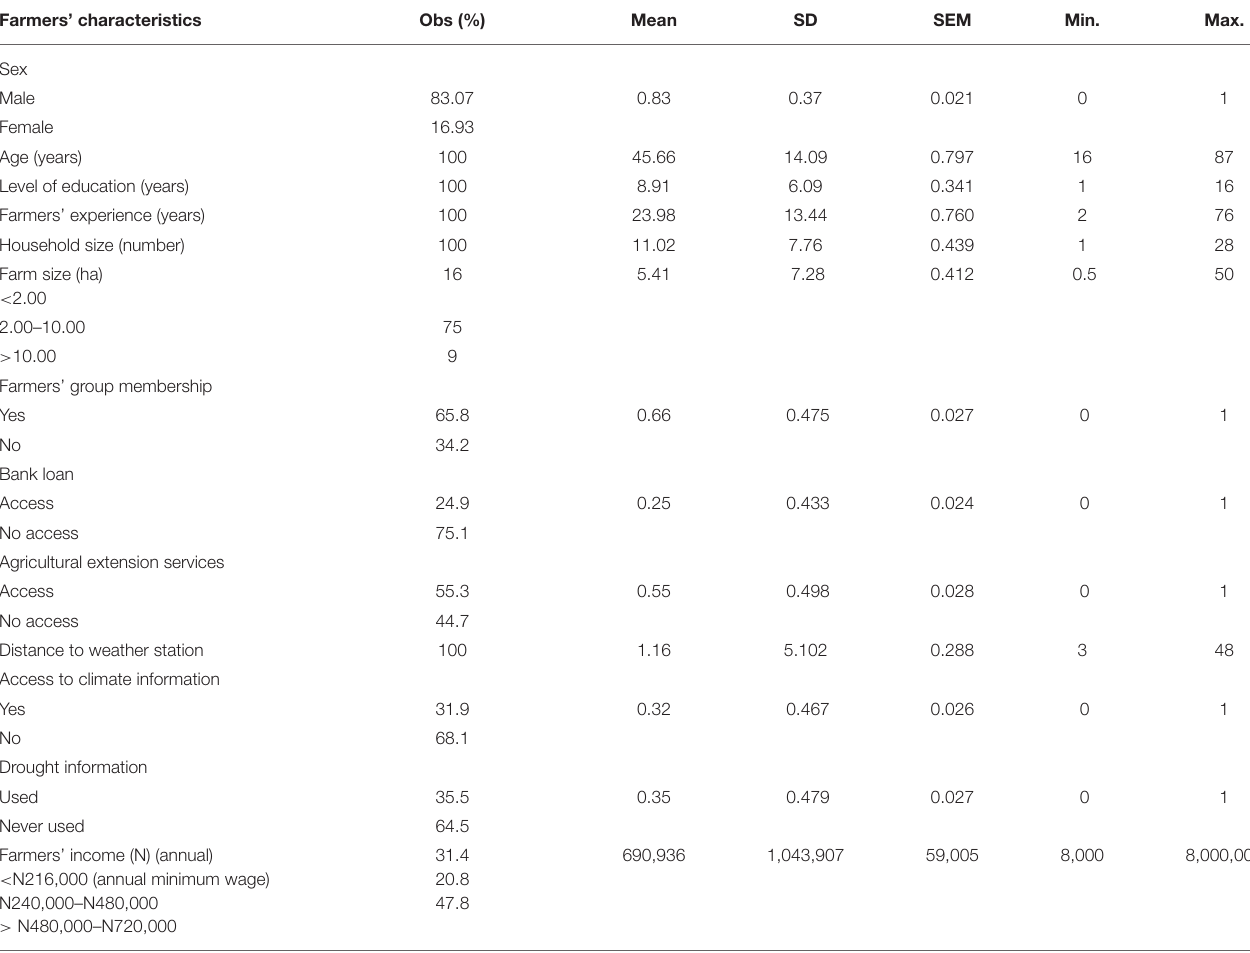
TABLE 4 | Socio-demographic characteristics of respondents. Farmers’